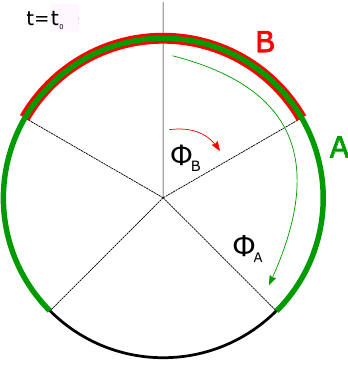
Figure 8 . Diagram of the spatial regions A and B considered for d = 1. (cid:30) is the azimuthal angle of the d sphere. The parameters (cid:30) A and (cid:30) B must verify 0 (cid:20) (cid:30) B (cid:20) (cid:30) A (cid:20) (cid:25) so that the condition B (cid:18) A